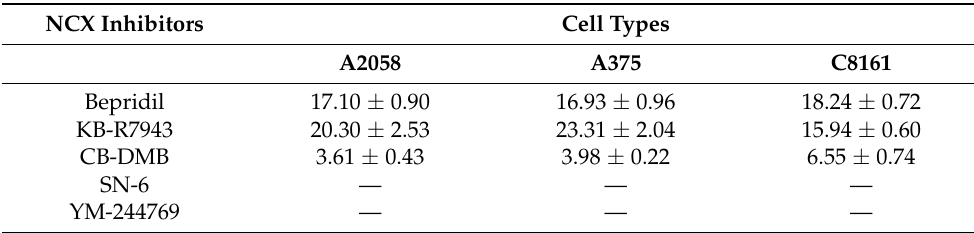
Figure 1. Effect of NCX inhibitors on viability of melanoma cells. ( A – C ) Viability of BRAF mutated human melanoma cell lines (A2058, A375, and C8161) after exposed to NCX blockers bepridil, KB-R7943, CB-DMB, SN-6, or YM-244769 at 0–100 µ M for 48 h. n = 4–5 independent tests per group. Table 1. The half-maximum inhibitory concentration values (IC 50 , µ M) of NCX blockers on viability of BRAF mutated melanoma